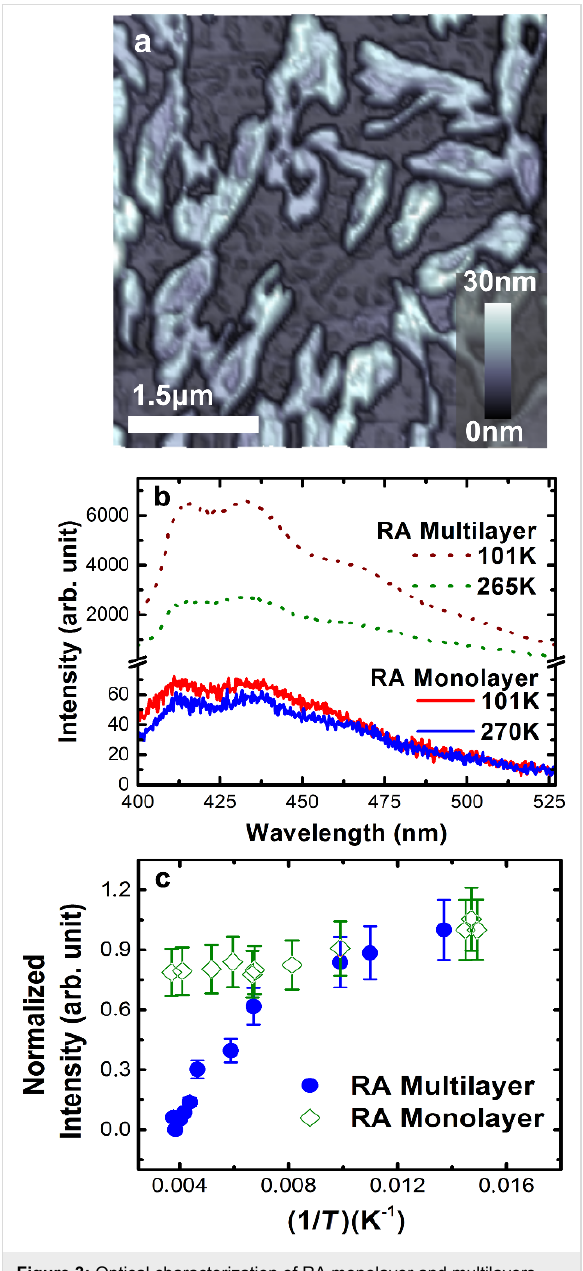
Figure 3: Optical characterization of RA monolayer and multilayers. (a) AFM topographic image of a multilayered RA sample deposited atop graphite microplate. (b) Photoluminescence spectra of RA mono- layer (solid lines) and multilayer (dashed lines) at two different temper- atures ( ≈ 100 K and ≈ 270 K). (c) Photoluminescence integrated intensi- ty as a function of the inverse of temperature for RA monolayer (green diamonds) and multilayer (blue circles). The laser excitation power (355 nm) was 1